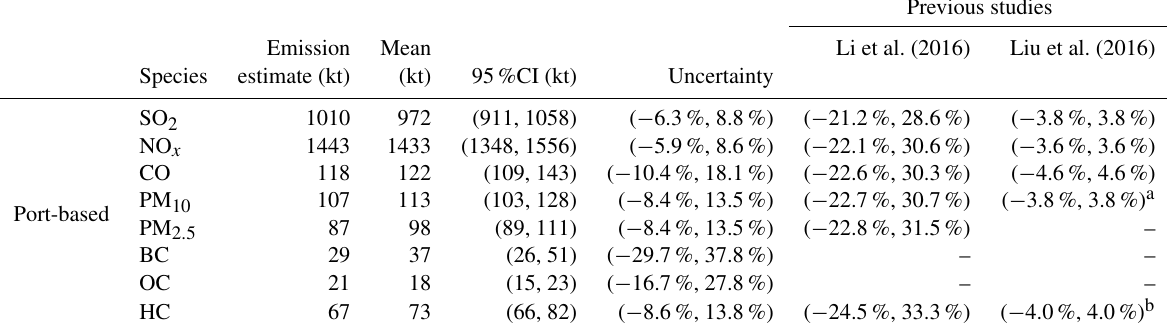
Table 9. Uncertainties in emission